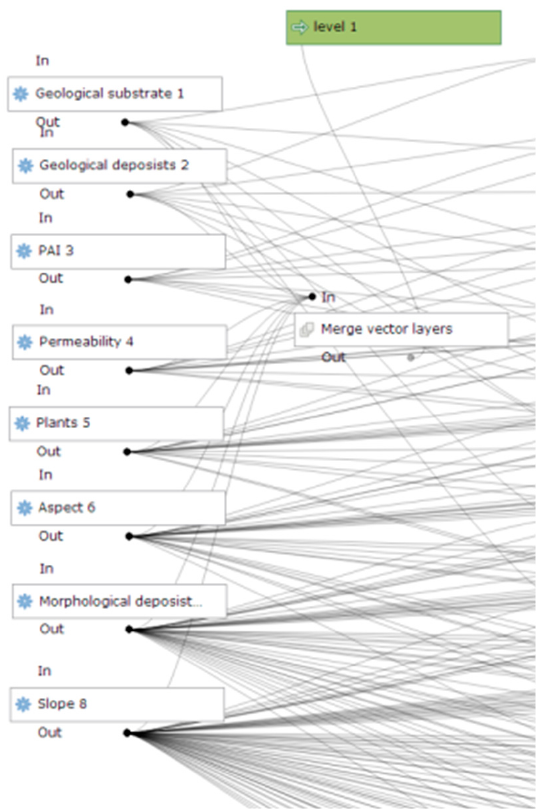
Figure 12. Architecture of the first level of susceptibility.